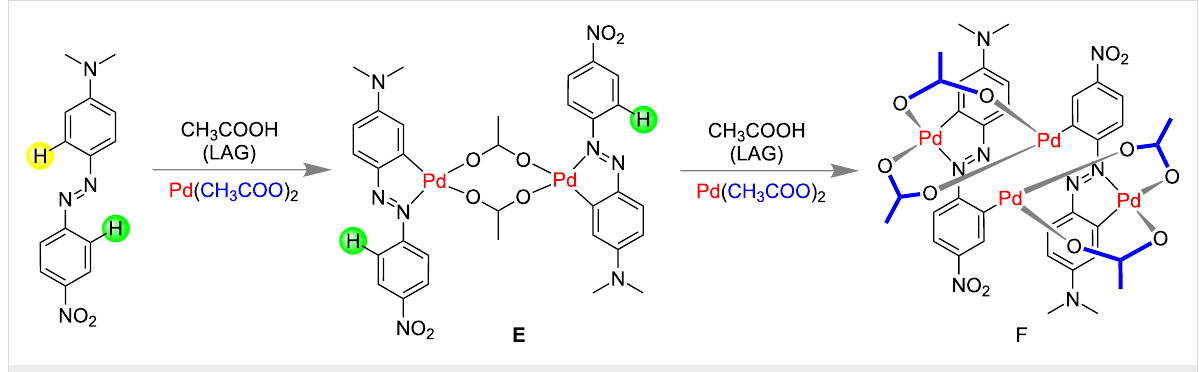
Scheme 46: Mechanochemical activation of C–H bond of unsymmetrical azobenzene [178].